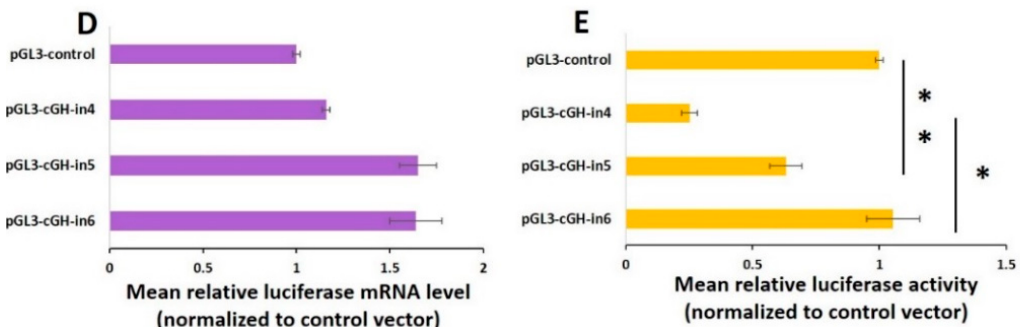
Figure 3. The effect of first intron fragments on promoter activity in GH4-C1. Reporter gene mRNA/protein expression level was measured 48 h after transient transfections in GH4-C1 cells. The mean relative luciferase mRNA/protein level was defined as the ratio between the firefly luciferase gene and the Renilla luciferase gene. ( A ) Diagrammatic representation of the fragments which inserted into the pGL3-control. The six fragments were cloned in the left orientation relative to the SV40 promoter. The solid lines represent the corresponding location of each fragment, while the dotted lines represent the sequences that were knocked out in the relevant fragment. The DNA region is located upstream of the transcription start site (designated +1); ( B ) the mean relative luciferase mRNA transfected with the four plasmids (pGL3-cGH-in1, pGL3-cGH-in2, pGL3-cGH-in3 and pGL3-cGH-in4); ( C ) the mean relative luciferase activity transfected with the four plasmids (pGL3-cGH-in1, pGL3-cGH-in2, pGL3-cGH-in3 and pGL3-cGH-in4); ( D ) the mean relative luciferase mRNA transfected with the three plasmids (pGL3-cGH-in4, pGL3-cGH-in5 and pGL3-cGH-in6); ( E ) the mean relative luciferase activity transfected with the three plasmids (pGL3-cGH-in4, pGL3-cGH-in5 and pGL3-cGH-in6). The purple or yellow columns represent the values, and bars indicate the standard error. Different lowercase or uppercase letters indicate a significant difference ( p < 0.05 or p < 0.01) when comparing the two indicated groups. Asterisks indicate a significant difference when comparing the two indicated groups, * means p < 0.05, ** means p < 0.01.